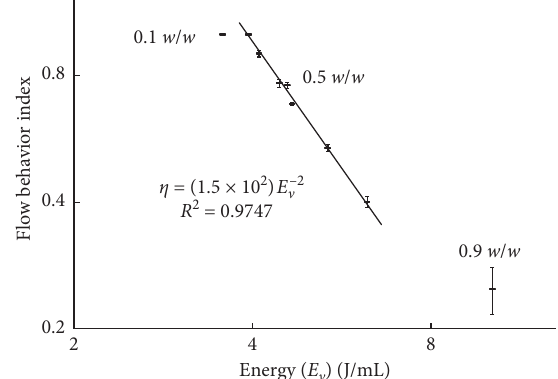
Figure 6: Flow behavior index (in log scale) as a function of the incorporated energy per volume (in log scale) for O/W emulsions within a concentration range between 10% w / w and 90% w / w (the concentration values increase in 10% w / w intervals). Excluding the points where the dispersed phase concentration is too low to have an impact on the rheological behavior of the system or too high to let the system rearrange after a strain, a novel, and concentration- independent relationship is proposed seen in the regression of the